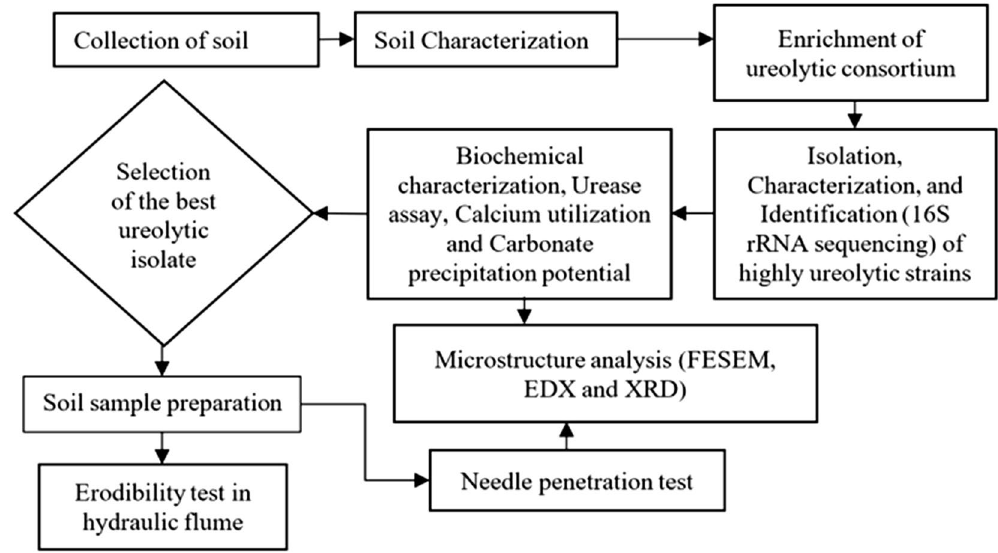
Figure 2. Schematic for the experiments in the current